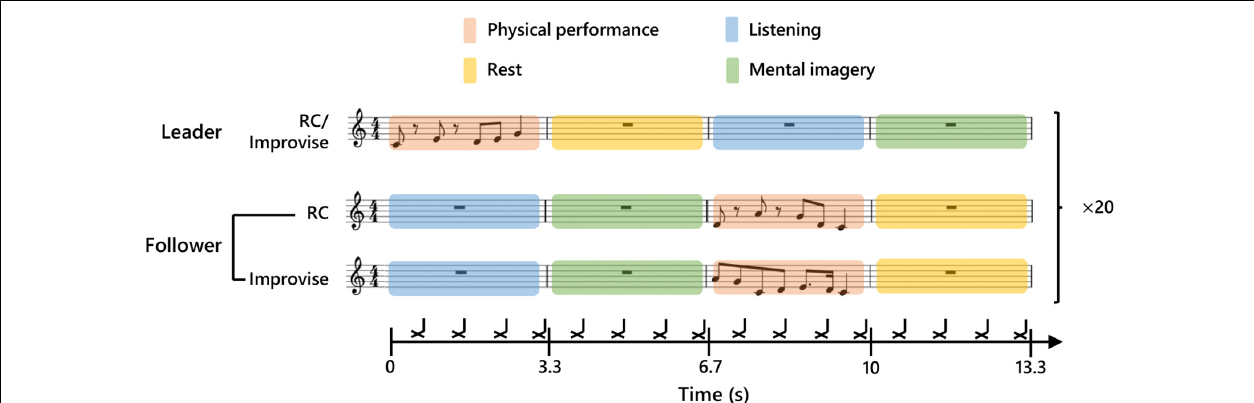
FIGURE 1 | Experimental paradigm. Schematic diagram of communication between Leader and Follower during a single experimental epoch. The upper part of the score shows an example of a Leader’s musical communication. The middle part shows an example of a Follower’s reply during the Rhythm Copy (RC) condition. Twenty consecutive communication epochs were performed for each condition. The lower part shows an example of a Follower’s reply during the Improvise condition. The black cross marks indicate the timing of a backbeat which was used to maintain tempo.